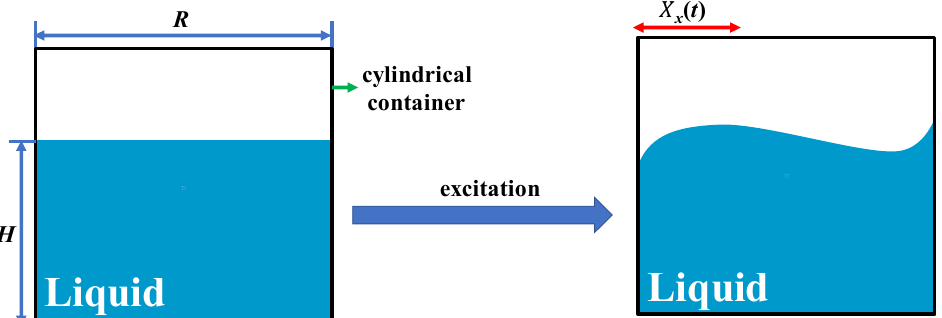
Figure 2. Schematic diagram of the liquid shaking.